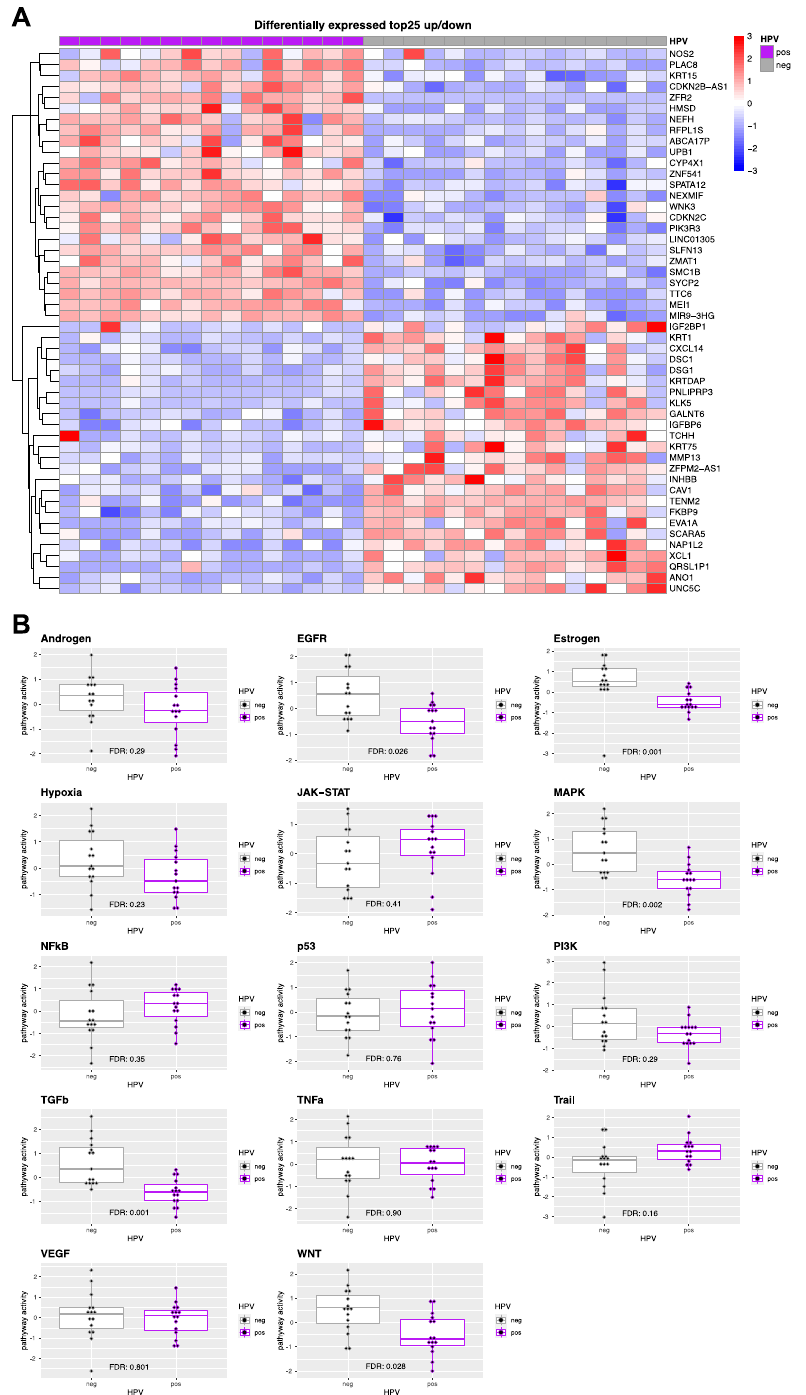
Figure 4. Differentially expressed genes and signaling pathway activity in 24-miRNA signature predicted HPV-positive versus HPV-negative HNSCC. ( A ) Heat map top 25 up-/down-regulated differentially expressed genes (adjusted p -value < 0.1 and |log2 fold change| > 0.5) in 24-miRNA signature positive and p16/HPV DNA-positive ( n = 15) versus 24-miRNA signature negative and p16/HPV DNA-negative ( n = 15) HNSCC of the LMU-KKG cohort. Heat map colours indicate mRNA expression z-scores on a scale of − 3 to 3. ( B ) Boxplots illustrate signaling pathway activity derived by progeny analysis of differentially expressed genes ( n = 658) in 24-miRNA-positive/HPV-positive ( n = 15) and 24-miRNA-negative/HPV-negative ( n = 15) HNSCC. Interquartile ranges with median centre lines are shown. FDR adjusted p -values are